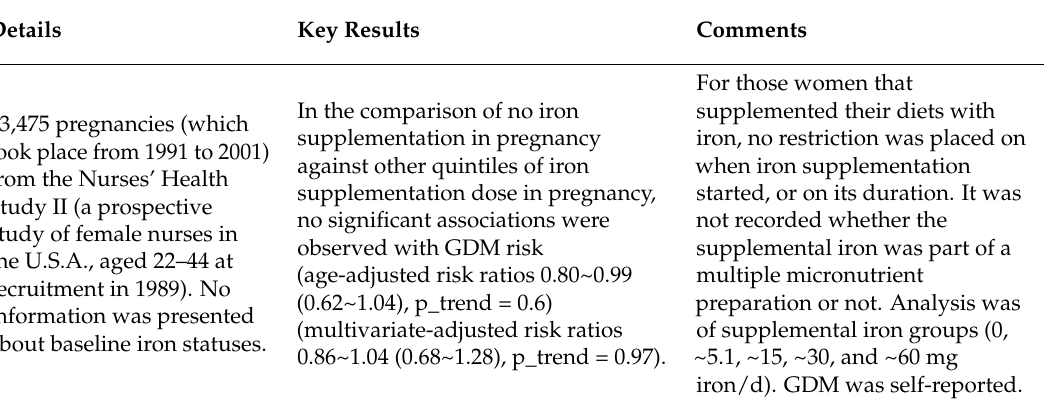
Table 4. Cohort studies that sought associations between iron supplementation in pregnancy and